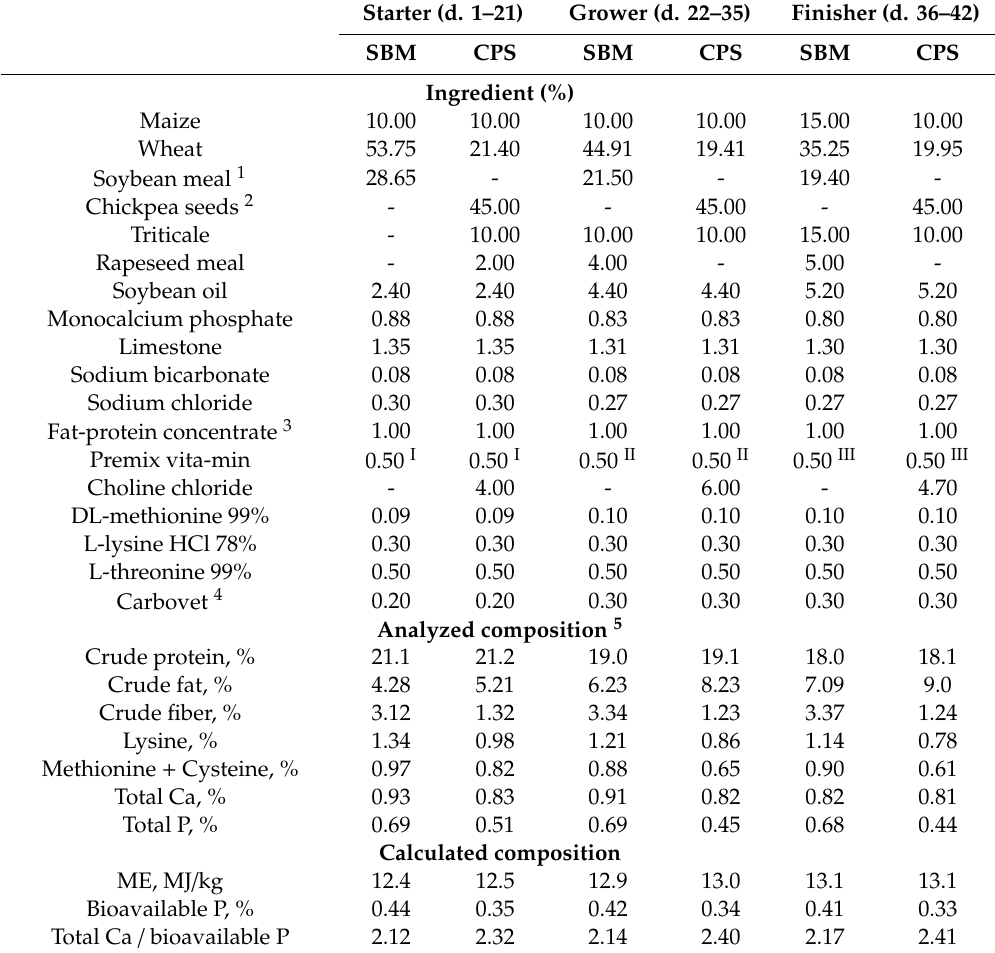
Table 1. Ingredients and nutrients content of control soybean meal (SBM) (as-fed basis) and experimental chickpea seed (CPS)